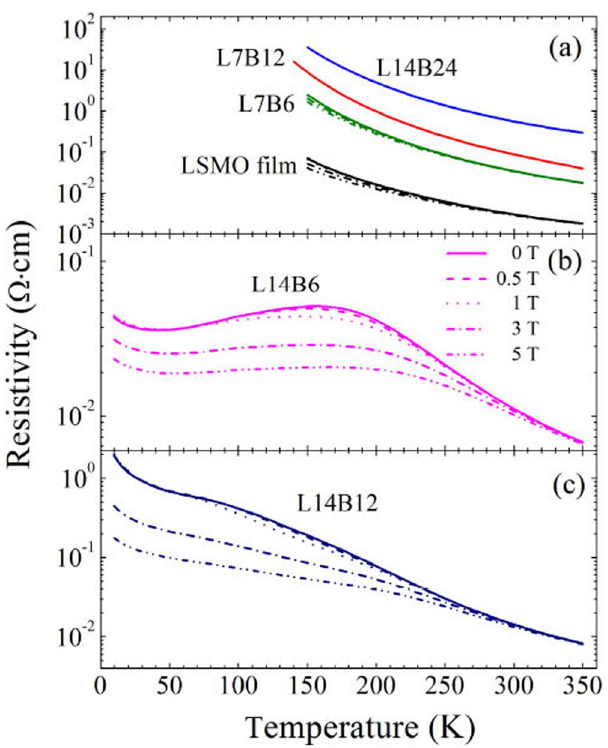
Figure 5. ( a–c ) Resistivity as a function of temperature for the superlattices and LSMO film in applied fields of 0, 0.5, 1, 3, 5